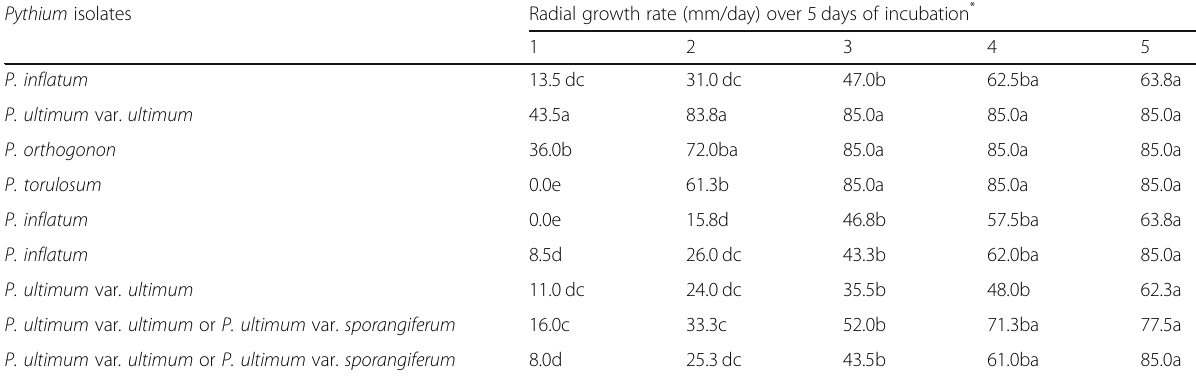
Table 1 Radial growth rate (mm/day) of Pythium isolates recorded at 24 h interval for 5 days Pythium isolates